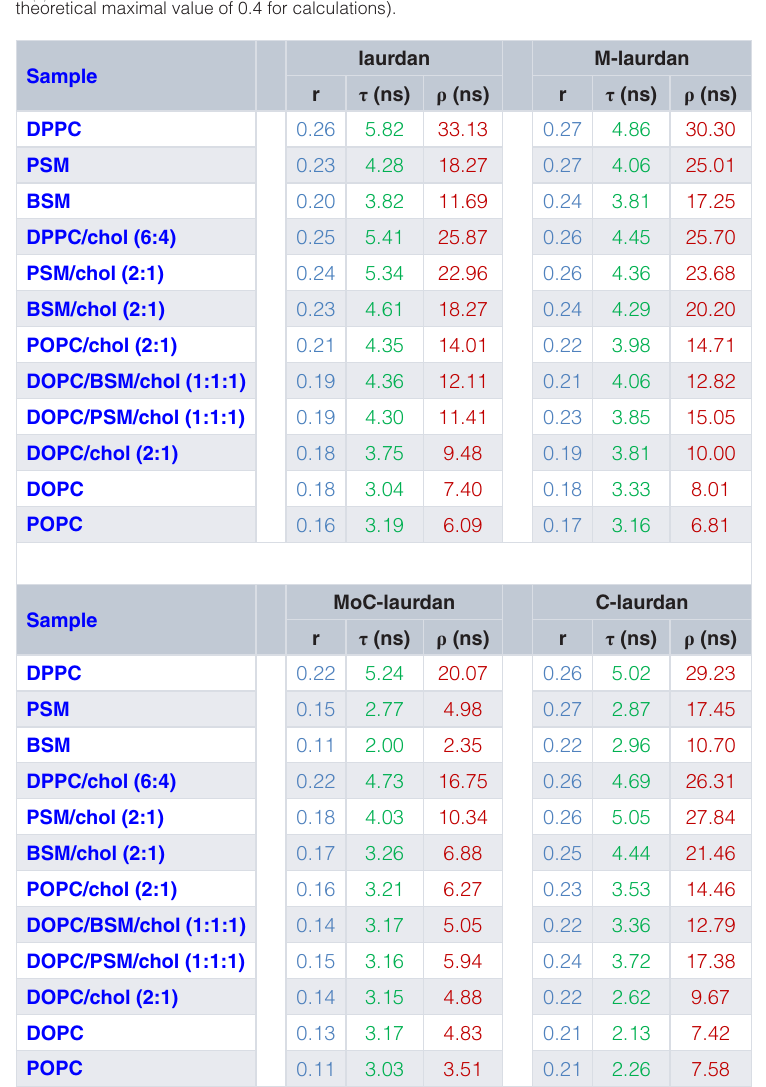
Supplemental Table S2. Rotational relaxation time ρ (ns) of laurdan, M-laurdan, MoC- laurdan and C-laurdan at 20°C. Anisotropy values (r) were converted into rotational relaxation time ( ρ ) taking into account the average lifetime ( τ ) of the probes using the following equation: 3 , [G. Weber, Adv. Prot. Res. 1953, 8, 415], where r 0 is the intrinsic anisotropy (set to the ρ τ = 1r   − r 0 theoretical maximal value of 0.4 for